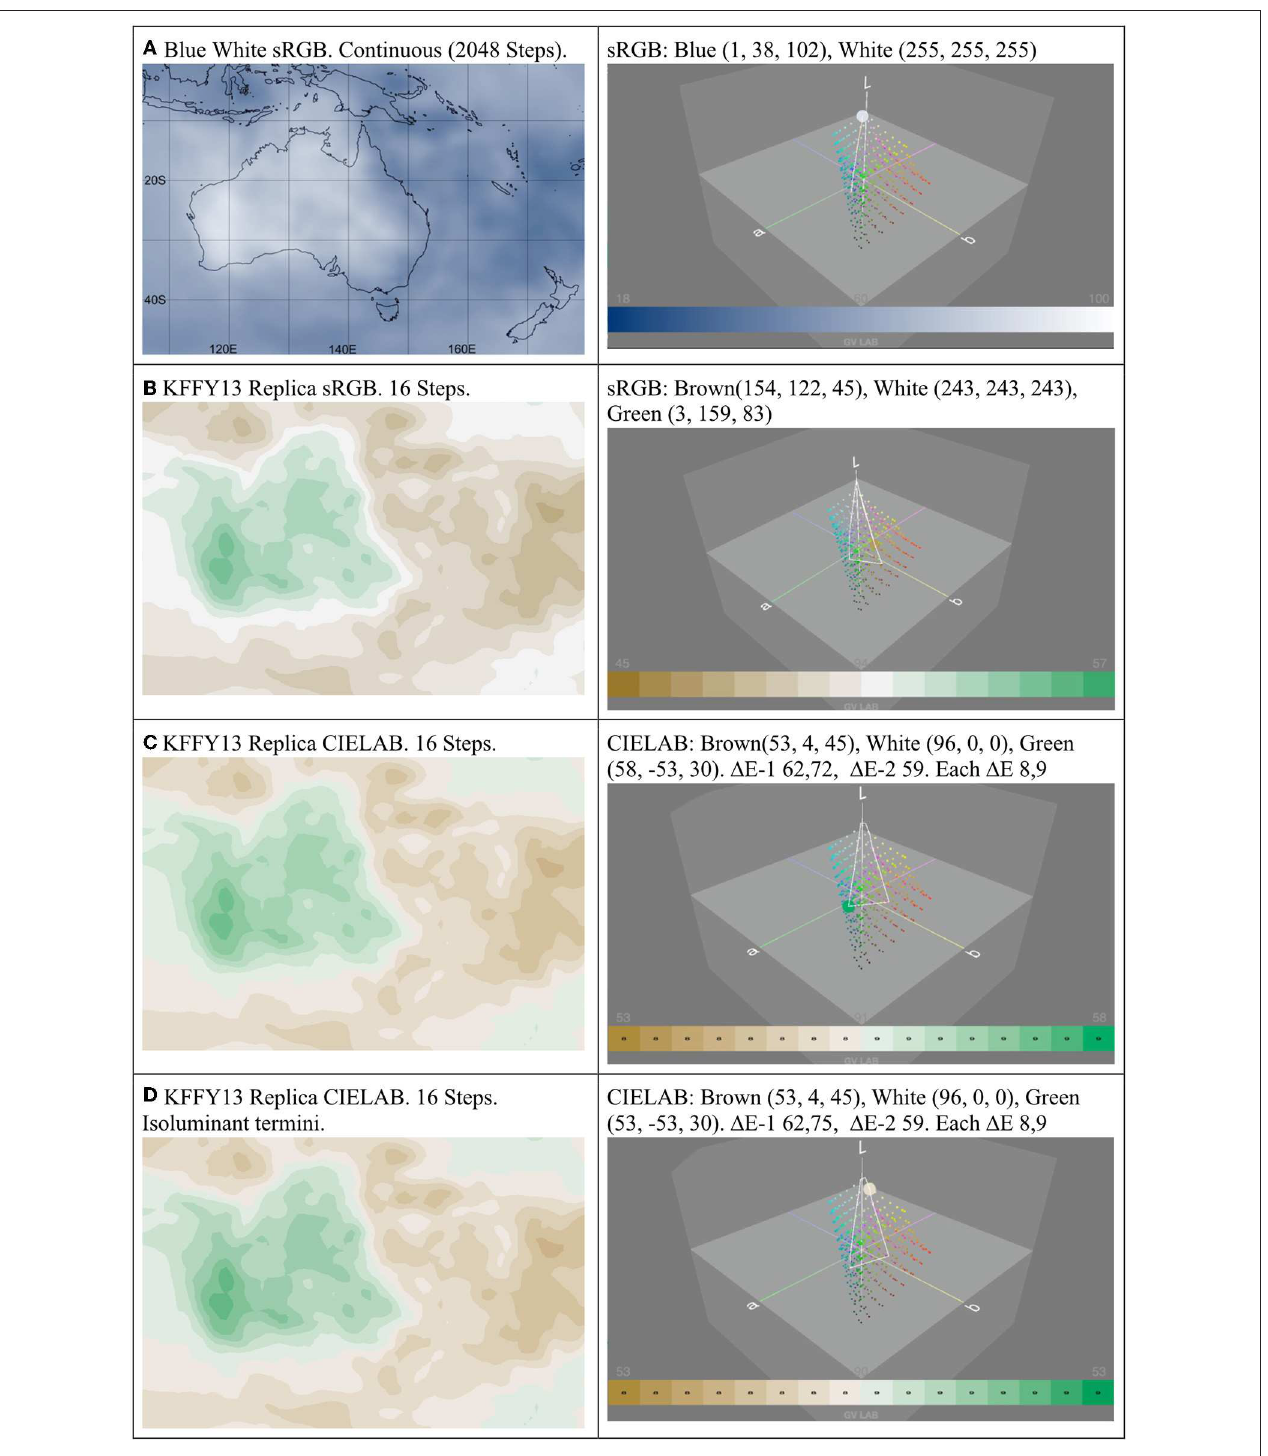
FIGURE 4 | Comparative visualizations generated using Gradient Designer and LAB Color Mixer Apps (left column) shown with supporting insights in CIELAB color space provided through the GV_LAB App (right column). The grid values being displayed are taken from the 100km depth slice (KFFY13). (A) Linearly interpolated HSL/sRGB reference view of the model in near-monochrome with slow values in dark blue; (B) Divergent 16 step RGB color-map replicating that used by KFFY13; (C) Divergent 16 step CIELAB interpolation replicating (B) ; (D) Divergent 16 step CIELAB interpolation with isoluminant end termini. All images assigned Generic RGB ICC profile. CIELAB colorspace conversions use D 65 2 ◦ illuminant. High resolution: https://doi.org/10.5281/zenodo.3264037.